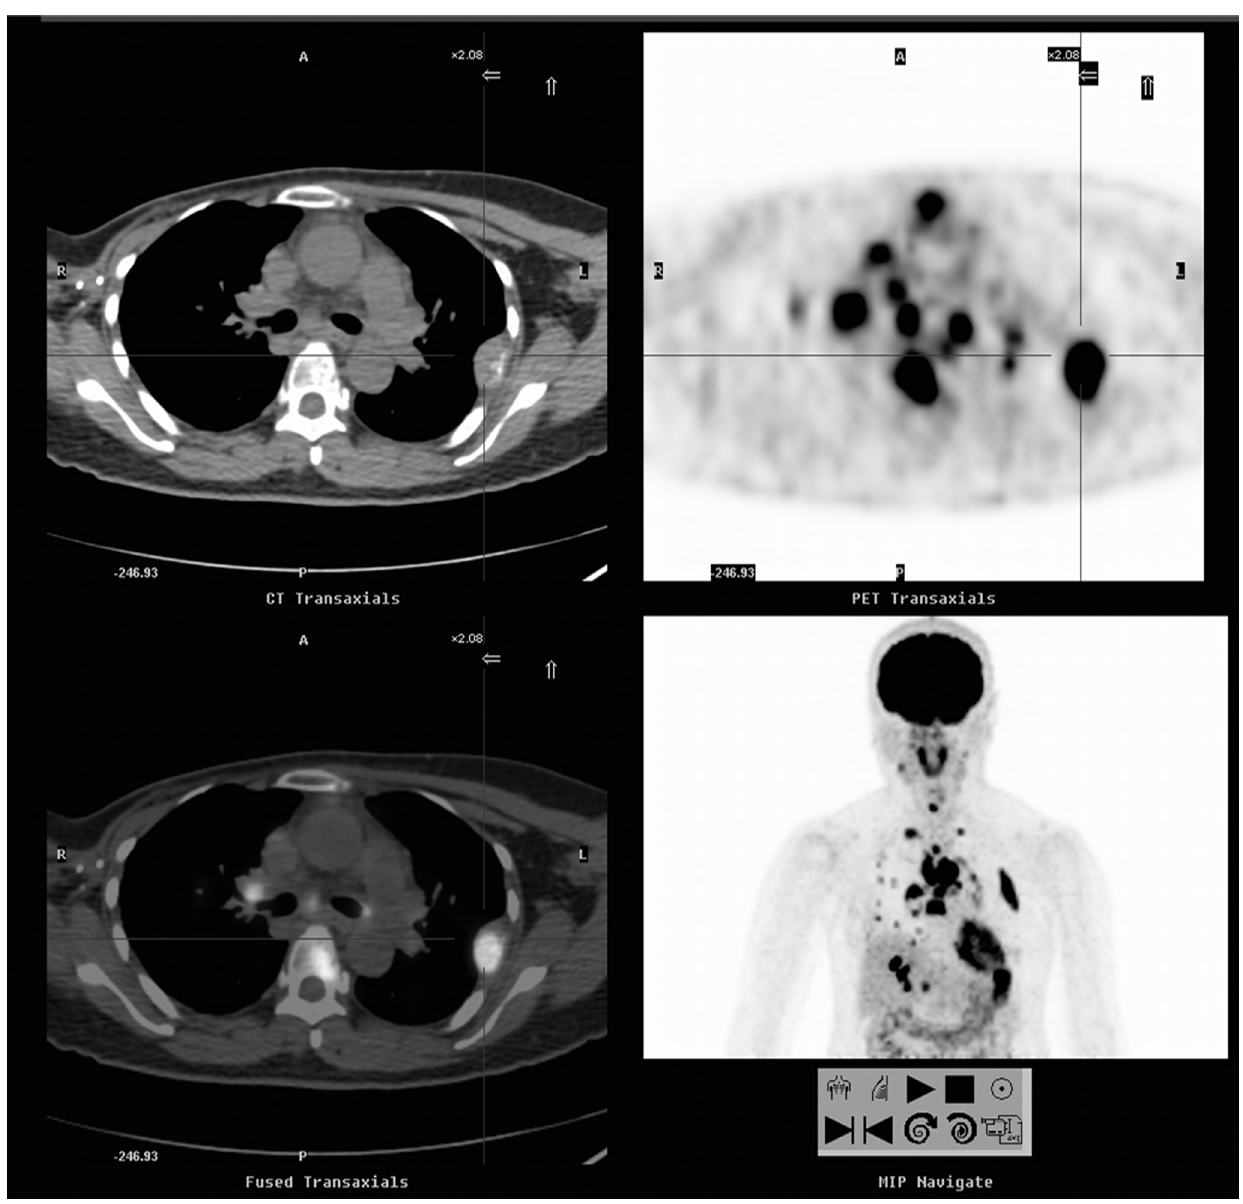
Fig. 1. A 55-year-old woman with a history of breast cancer (invasive ductal carcinoma of the right breast, stage I) underwent a FDG-PET/CTscan due to elevated serum CA15-3 level of 44.7 U/ml. FDG-PET/CT showed local recurrence in right anterior chest wall, extensive lymphatic invasion, and multiple metastases to liver, lungs and bones (SUVmax 5 17.5, cross cursor). The patient’s disease progressed rapidly, and she expired 8 months later. FDG-PET/CT, 2-[ 18 F]fluoro-2-deoxy-Dglucose-positron emission tomography/computed tomography; SUV, standardized uptake